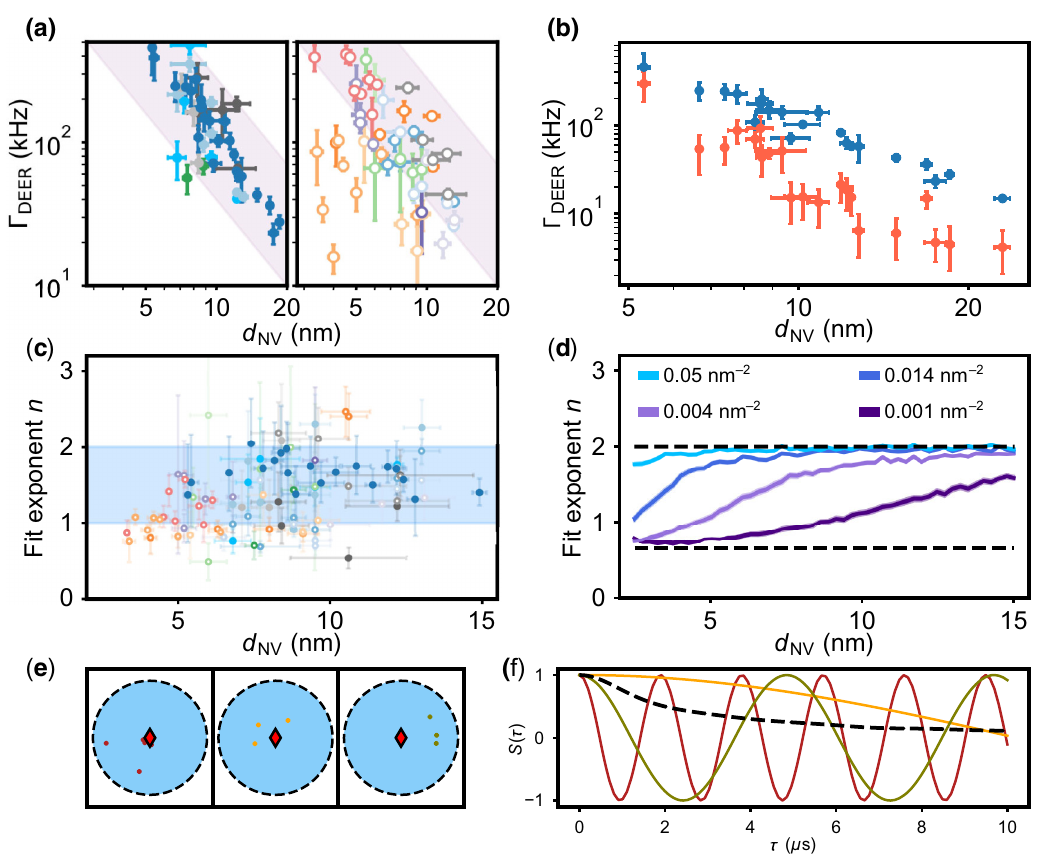
FIG. 2. DEER coupling rates and stretching factors. (a) Fitted DEER couplings as a function of depth for numerous NV centers. Colors represent NV centers measured in a particular sample, while each data point is an individual NV center measurement. All samples in the left plot have nominally identical surface preparations (activated or reset surface, SI), while samples in the right plot represent different surface preparations. Surface preparation details and the sample color key are available in Appendix A. Shaded region indicates expected couplings for surface spin densities of 0.001–0.05 nm − 2 , according to Eq. (1). The lower limit corresponds to an average nearest-neighbor spin-spin separation of approximately 15 nm, while the upper limit is chosen to encompass the largest (cid:5) DEER shown. (b) DEER coupling versus depth for the same NV centers in Sample 8 before (blue) and after (red) annealing at 650 (c) Fitted exponent as a function of depth for samples in (a). Filled markers are samples with similar surfaces. Shaded region indicates exponents between 1 and 2. (d) Fits of the exponent versus depth for simulated data. Colors indicate different simulation spin densities of 0.05 nm − 2 (light blue), 0.014 nm − 2 (dark blue), 0.004 nm − 2 (light purple), and 0.001 nm − 2 (dark purple). Shaded regions are confidence intervals for fits of simulated data. Dashed lines indicate limiting values of n = 2 and n = 2 / 3. (e) Monte Carlo simulation instances of random spin configurations with spin density 0.005 nm − 2 (dots) relative to a NV center that is 4 nm deep (red diamond). Plotted spins fall within an 8-nm radius circle of the NV center (dashed circle). (f) DEER signals for the representative configurations of (e), where signals from individual repetitions are dominated by a few nearby spins. Configurational averaging over 10 000 iterations gives rise to exponential decay (dashed line). All error bars are 68% Bayesian credible intervals of the fit parameters. bath, this exponent saturates at n = 1, so the observation of n < 1 for many NV centers is surprising.